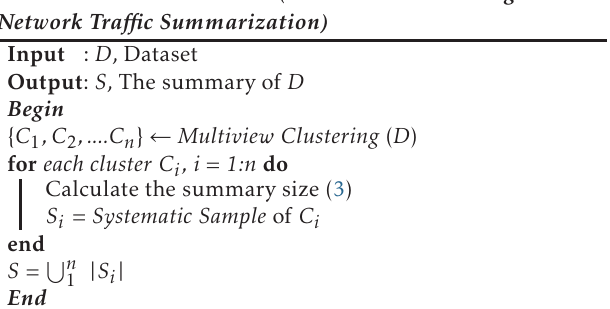
ALGORITHM 3: MCNTS(Multiview Clustering based Network Tra ffi c